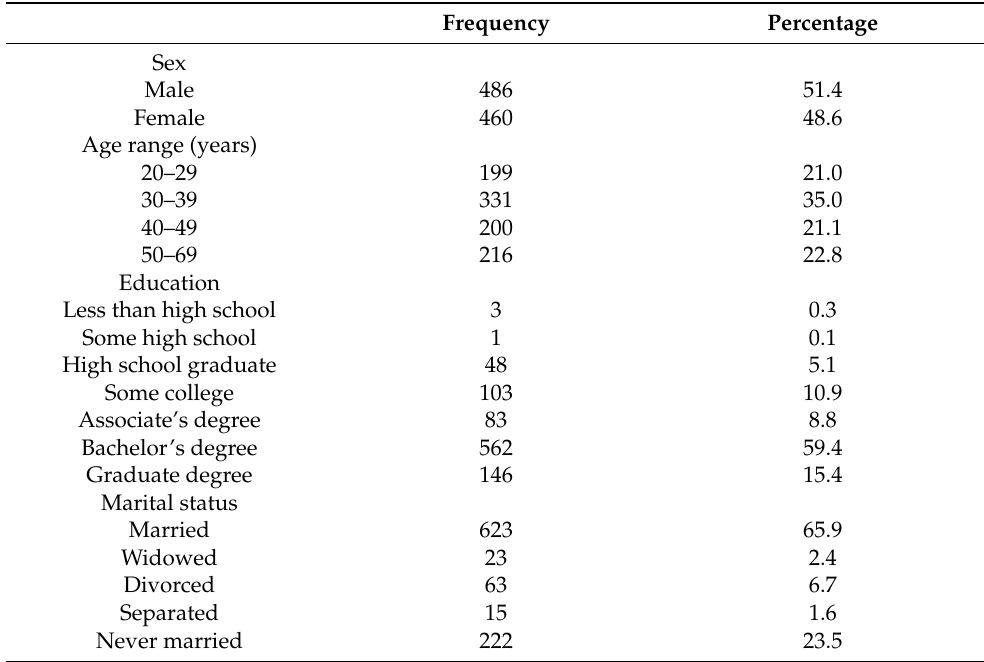
Table 1. Demographic characteristics of US adults who completed the COVID-19 and Food Waste Questionnaire ( N = 946).